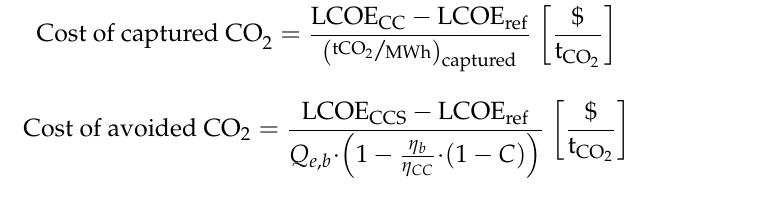
(cid:110) (cid:104) ( 1 − f ) x (cid:105) (cid:111) + ln ( 1 − fx ) − ln ( 1 − f ) ln (cid:4666)(cid:2869)(cid:2879)(cid:3033)(cid:4667)(cid:3051) fx f 1 − fx (cid:4675) + (cid:3039)(cid:3041)(cid:4666)(cid:2869)(cid:2879)(cid:3033)(cid:3051)(cid:4667) − (cid:3039)(cid:3041)(cid:4666)(cid:2869)(cid:2879)(cid:3033)(cid:4667) (cid:4677) [19]. (cid:2869)(cid:2879)(cid:3033)(cid:3051) (cid:3033)(cid:3051) (cid:3033)